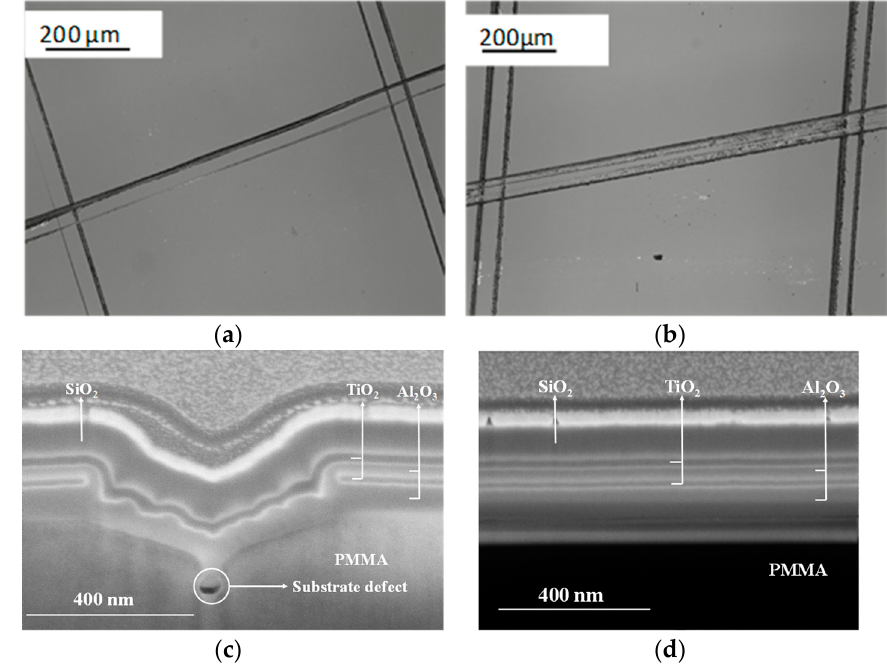
Figure 7. ( a ) Optical microscopic images after cross-hatch tests of AR-D1 double-sided coated PMMA, and ( b ) double-sided AR coating AR-D2 sample after climate test demonstrate their environmental stability, ( c ) focused ion beam scanning electron microscopy (FIB-SEM) cross-sectional image of single-sided five-layer AR coating on PMMA (focused on a crack), ( d ) FIB-SEM cross-sectional image of single-sided five-layer AR coating on PMMA (focused on a crack-free region).